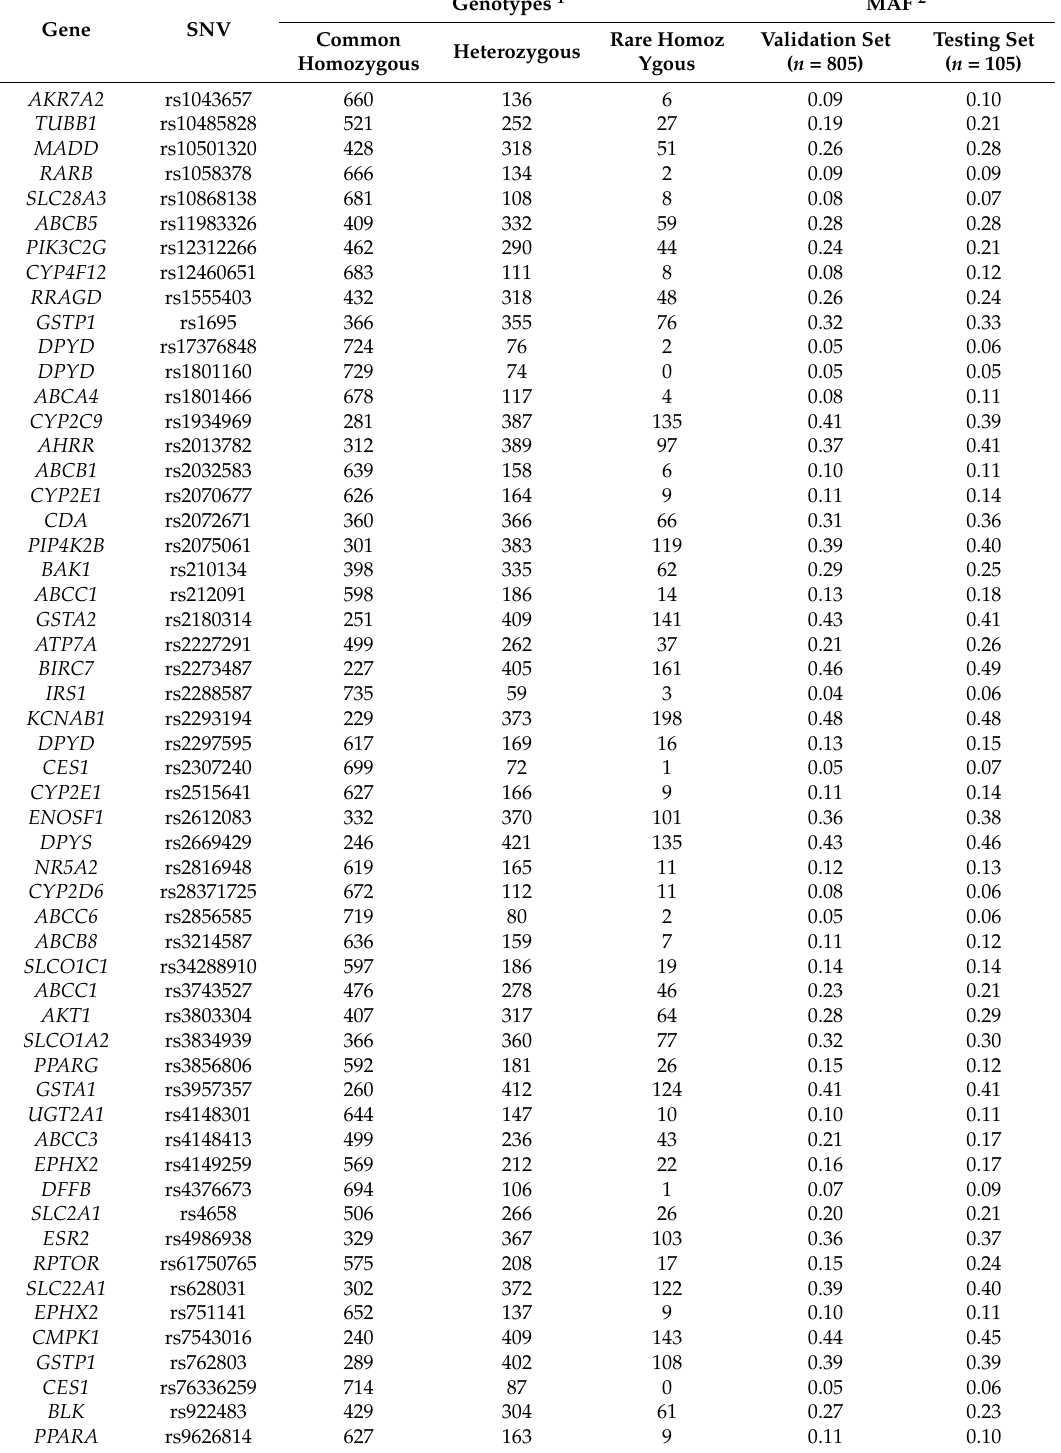
Table 7. Distribution of genotypes for variants assessed in the validation